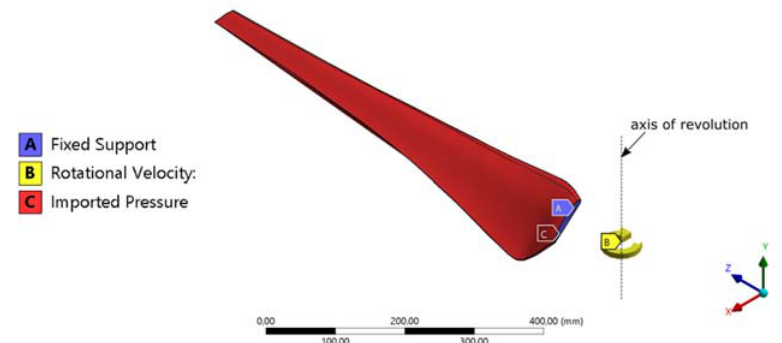
Figure 7. Applied loads and boundary conditions.